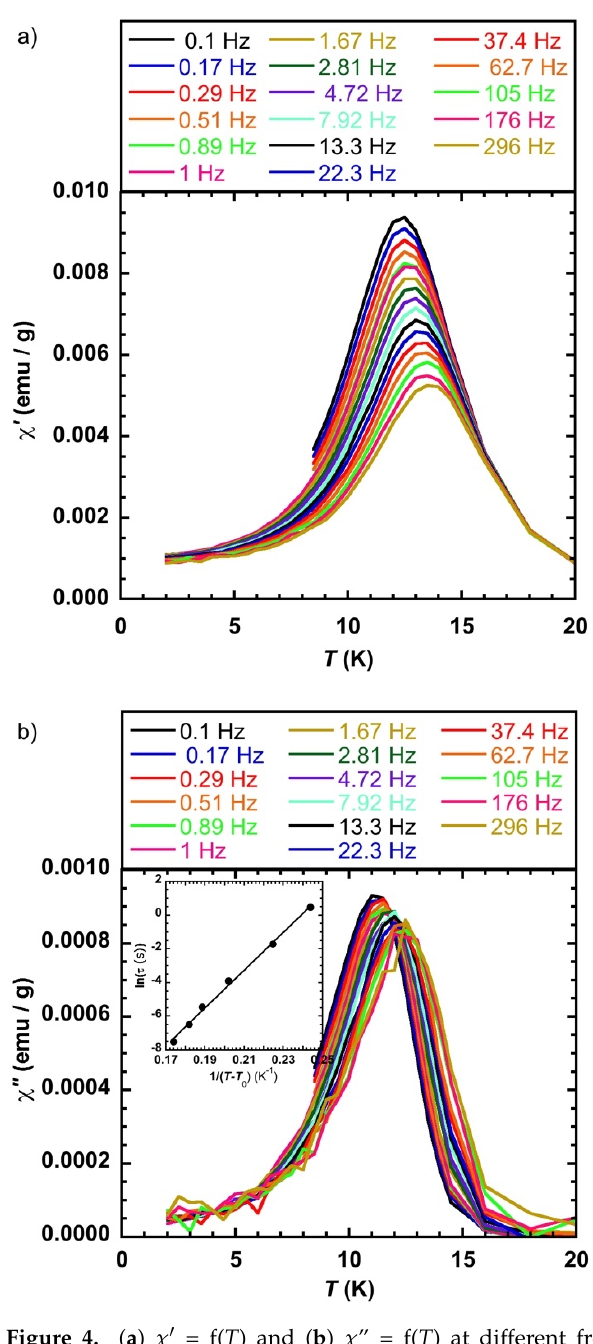
Figure 4. ( a ) χ ’ = f( T ) and ( b ) χ ” = f( T ) at different frequencies of the alternating magnetic field (3 Oe), inset ln( τ ) = f(1/( T − T 0 )) and linear fit with values in the text, CsCoFe_CTA; laser power = 50 mW/cm 2 .